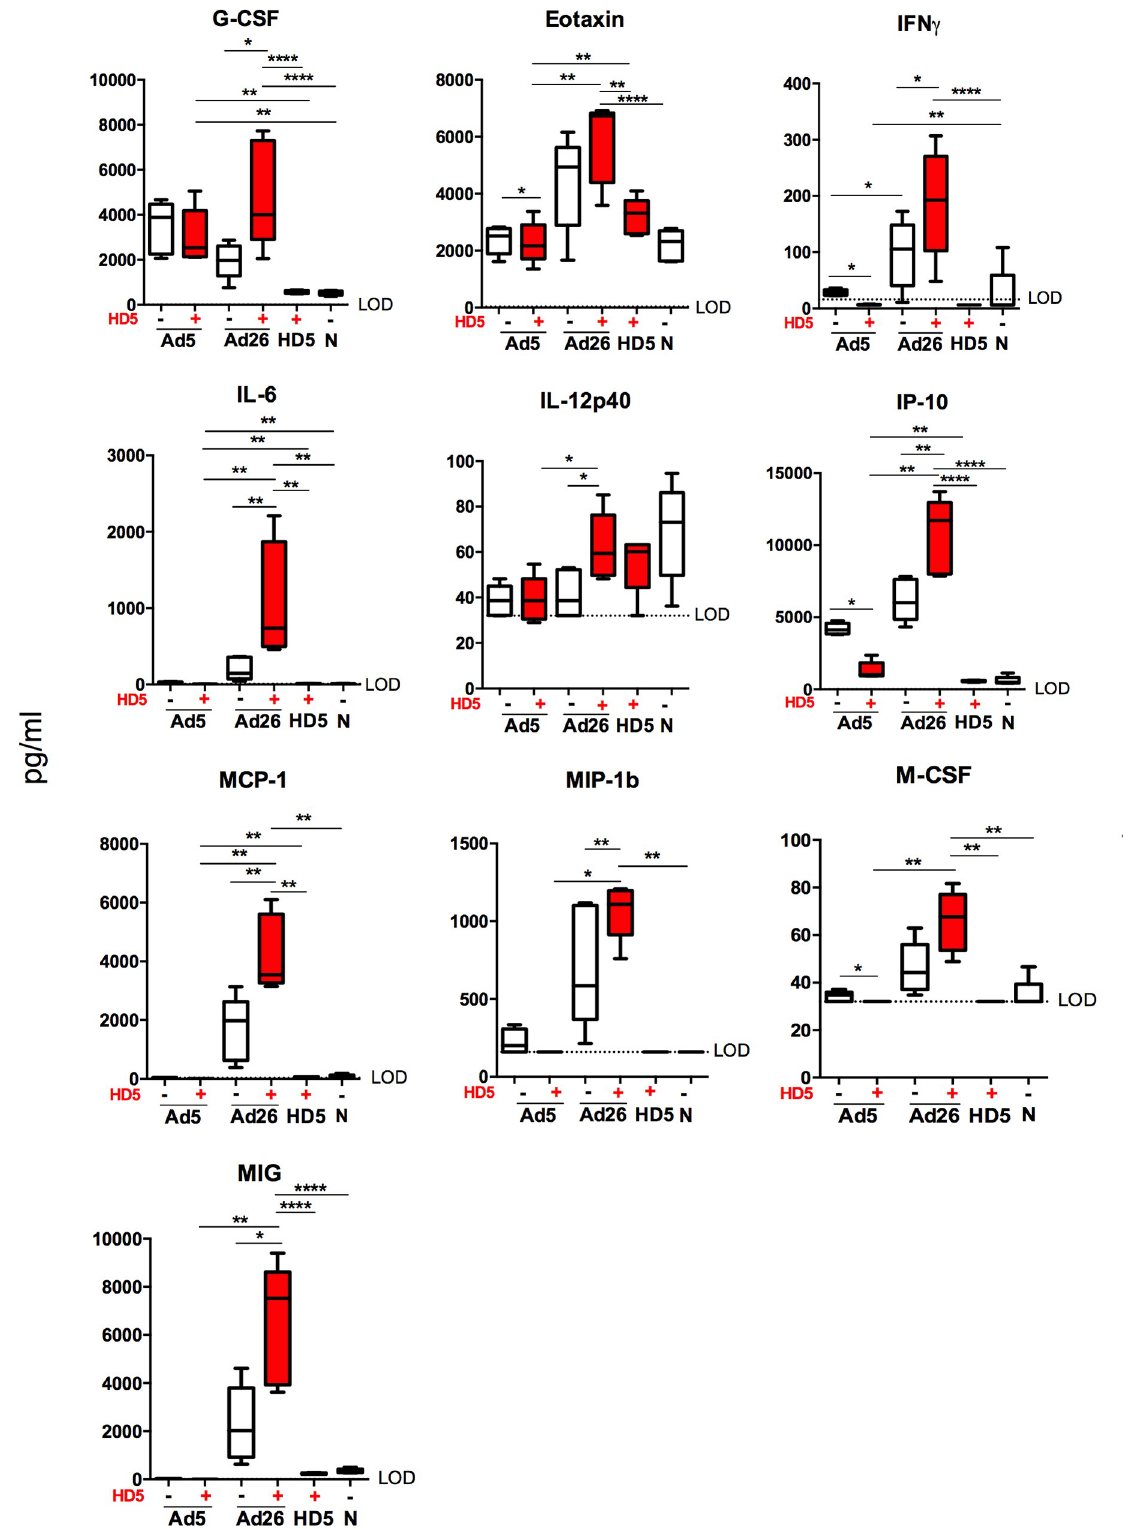
Fig 4. Ad5- and Ad26-elicited cytokine and chemokine responses in mice. C57BL/6 mice (n = 5/group) were administered i.m. with either PBS or 100 μ M HD5 and Ad5 (10 10 vp) or Ad26 (10 10 vp) empty vectors. Box plots for selected cytokines that show